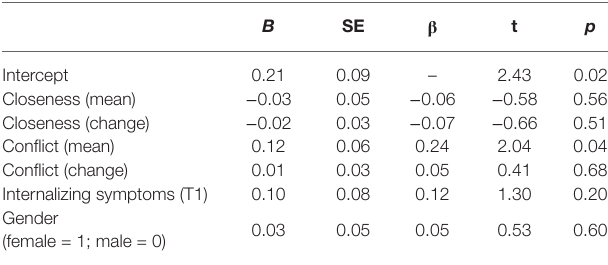
TABLE 7 | From middle to high school: T2 internalizing symptoms on student- teacher relationship scale variables ( N = 117, R 2 = 0.07). B SE β t p Intercept